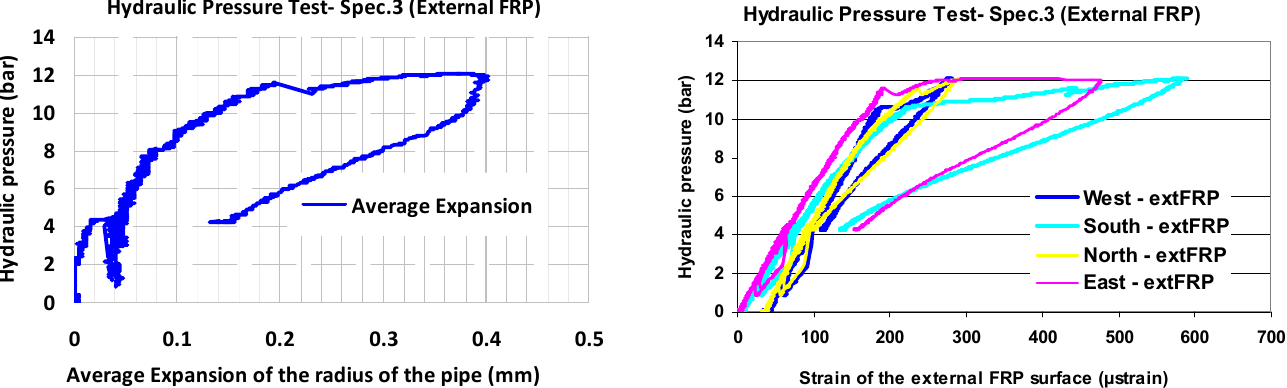
Figure 17. Measured response for Specimen 3 with fully active prestressing and an external FRP jacket: ( Left ) average radial expansion; ( Right ) radial strains of the external FRP jacket (1 bar = 0.1 N/mm 2 ).